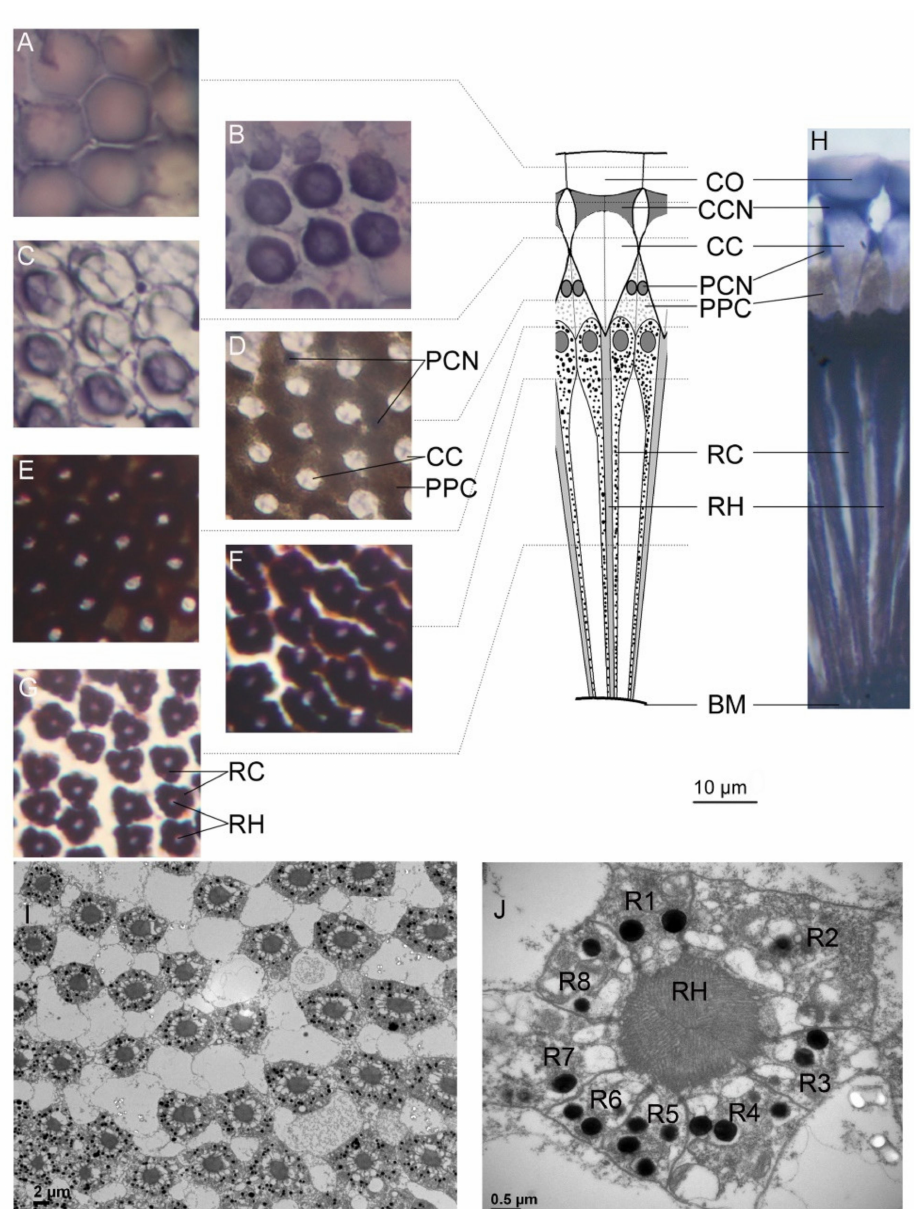
Figure 3. Fine structure of the ommatidium in Empoasca onukii adults: The transverse ( A – G ) and longitudinal ( H ) sections of ommatidia are shown with light micrographs, and the detailed transverse ( I , J ) sections of an ommatidium are shown with transmission electron micrographs. The dioptric apparatus of the ommatidium consists of the cornea ( A ) and the crystalline cone ( B , C ). The crystalline cones are surrounded by the primary pigment cells and are insulated from each other ( D ). In physical contact with the crystalline cone ( E ), the light-sensitive fused rhabdom is formed by eight retinular cells ( F , J ). The ommatidia are separated from each other in the middle section of the rhabdom ( G , I ). The fused rhabdom is formed by eight retinular cells, 1–8 ( J ). CO, cornea; CC crystalline cone; CCN, nucleus of cone cell; PPC, primary pigment cell; PCN, nucleus of primary pigment cell; RC, retinular cell; RH, rhabdom; R1–R8, retinular cells 1–8; BM, basement membrane. Scale bar = 10 µ m in ( A – H ), 2 µ m in ( I ), and 0.5 µ m in ( J